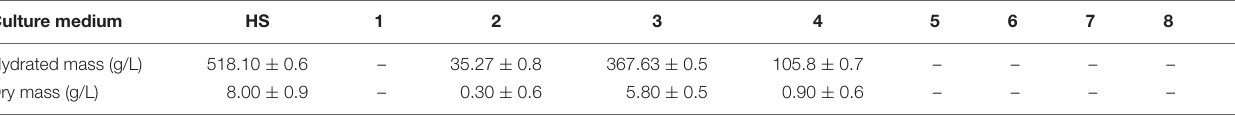
TABLE 3 | Hydrated and dry mass of BC pellicles produced in alternative media compared to HS medium. Culture medium HS Hydrated mass (g/L)